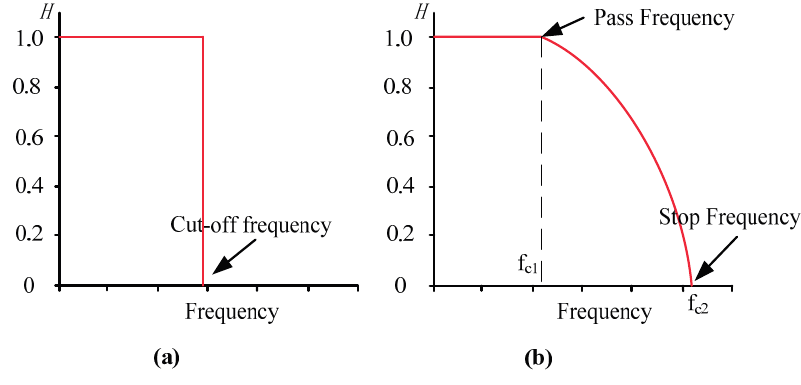
Figure 1. Window form of filters. ( a ) TLPF; ( b ) PFFTF.